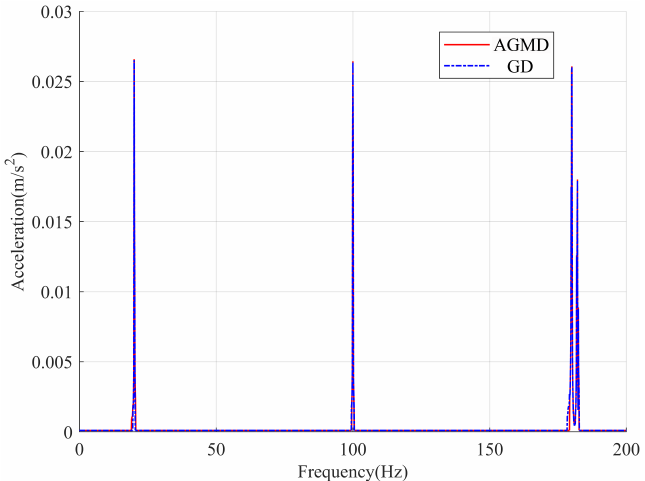
Figure 11. Comparison of acceleration spectrum after denoising 30% noise energy by